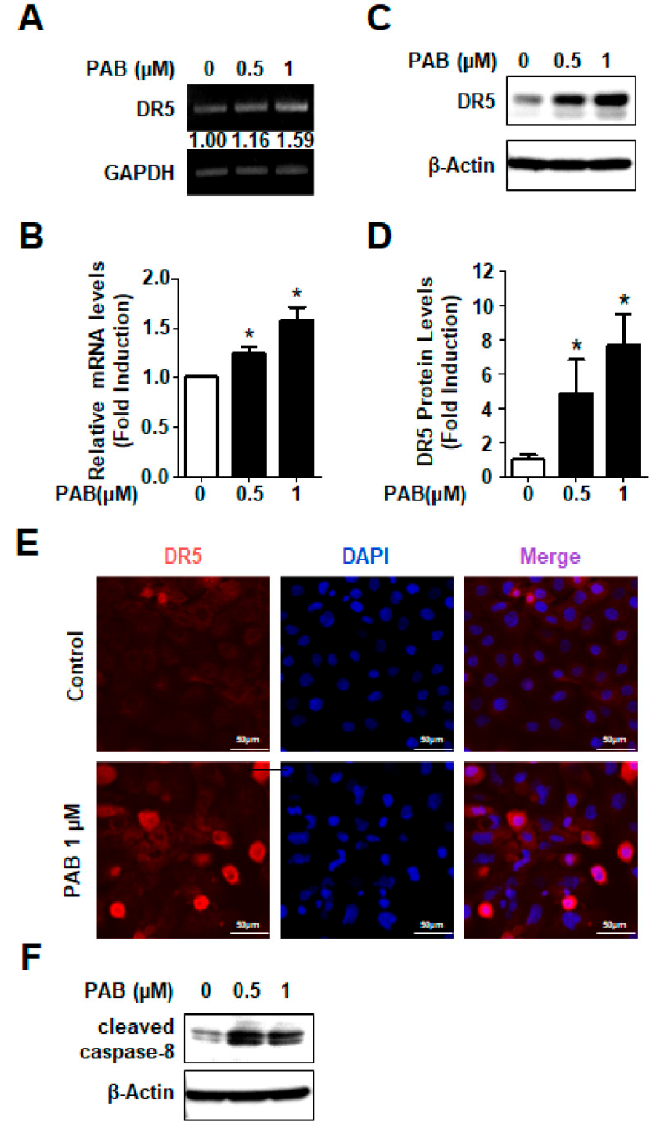
Figure 3. Involvement of DR5 in PAB-induced apoptosis in HN22 cell line. ( A ) DR5 mRNA was determined by RT-PCR. ( B ) mRNA levels were measured by QPCR. ( C ) HN22 cells were treated with DMSO or designated concentrations (0.5 and 1 µm) of PAB for 24 h as in subjected to DR5 protein and analyzed by western blotting. ( D ) The graph depicts the mean ± SD of triplicates. (* p < 0.05) ( E ) DR5 protein was detected by immunofluorescence staining (magnification, X400). ( F ) Cleaved caspase-8 was detected by western blotting.